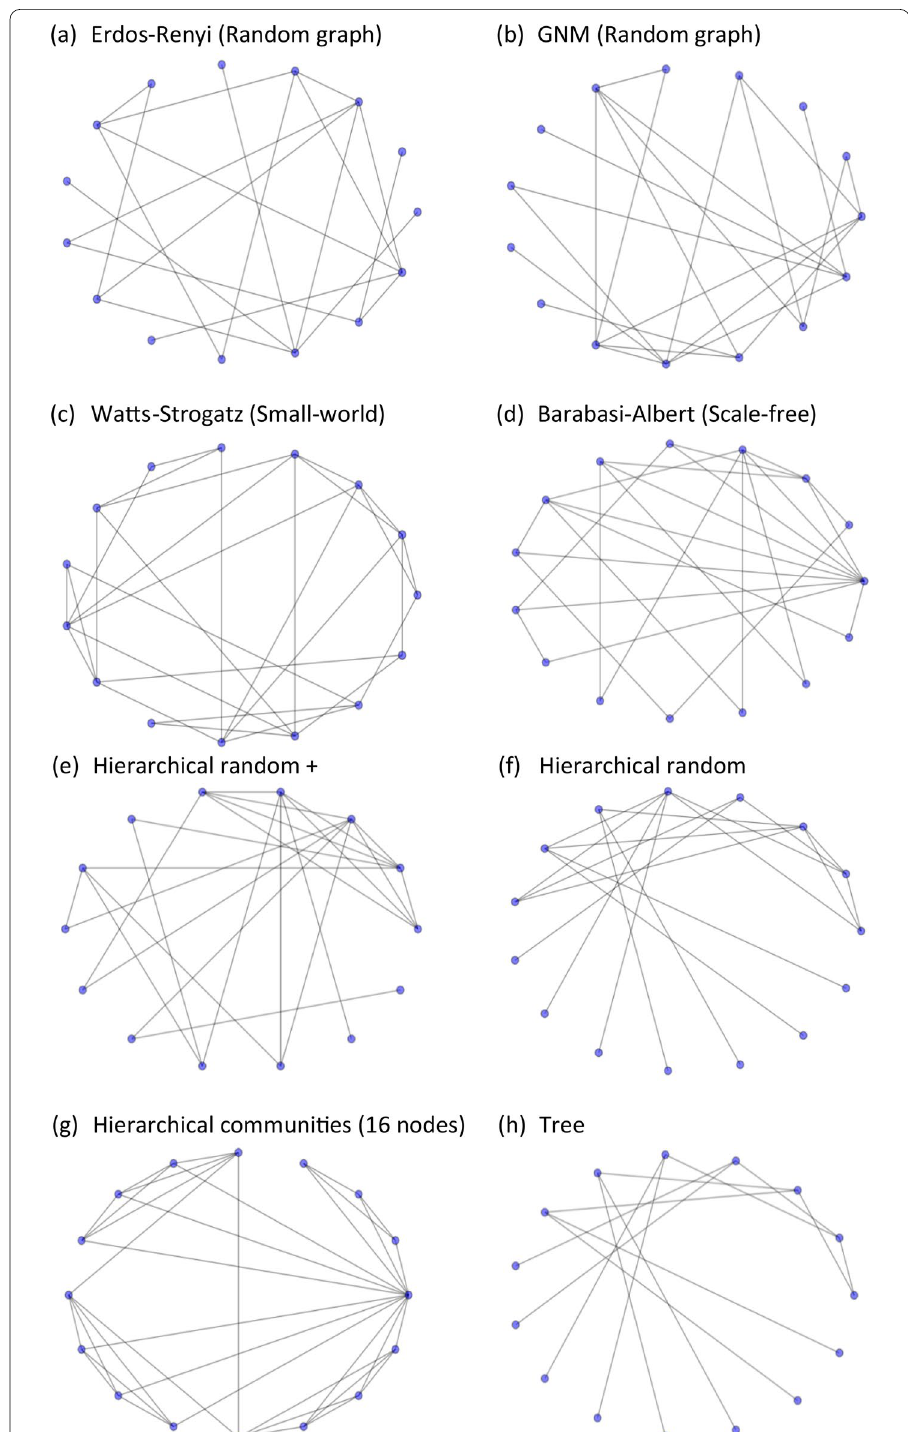
Fig. 2 The topology of the eight graph models in the suite of synthetic networks, each with 15 nodes, except the HC model (g) which has 16, shown using a circular